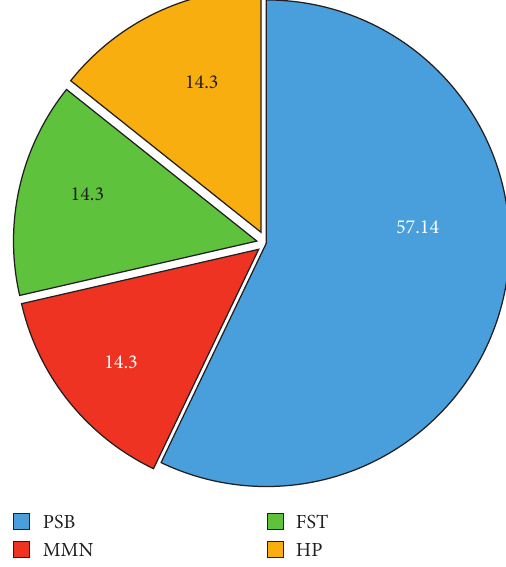
Figure 6: Cumulation of playgrounds and historical and/or cul- tural monuments by green spaces. Prefecture garden (HP), Marien Ngouabi Museum garden (MMN), Ministry of Mines square (MM), Pierre Savorgnon De Brazza garden (PSB), and Faculty of Science and Technology square